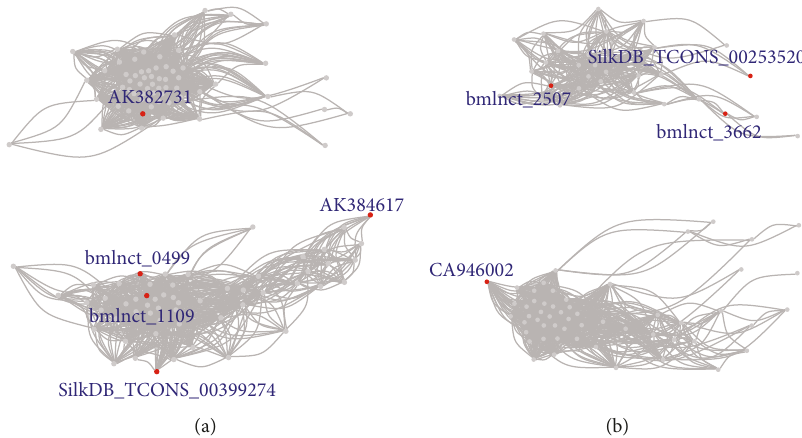
Figure 8: Network visualization. (a) Connections within the blue module. (b) Connections within the red